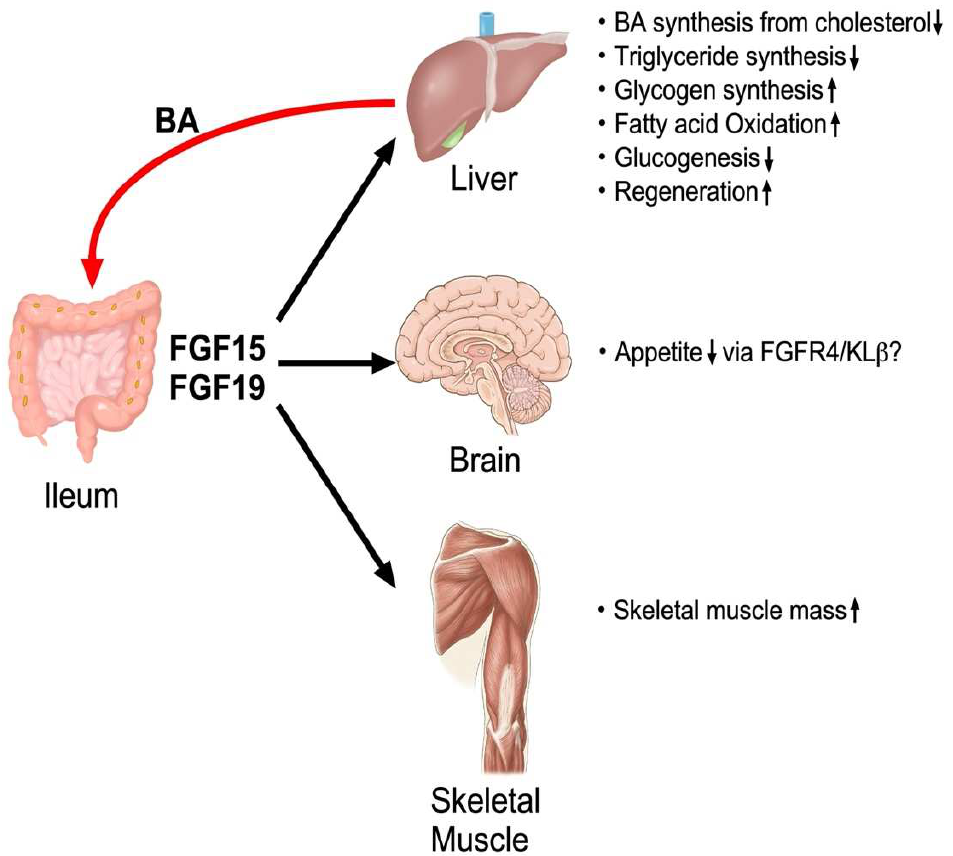
Figure 4. Overall physiological function of FGF15/19.